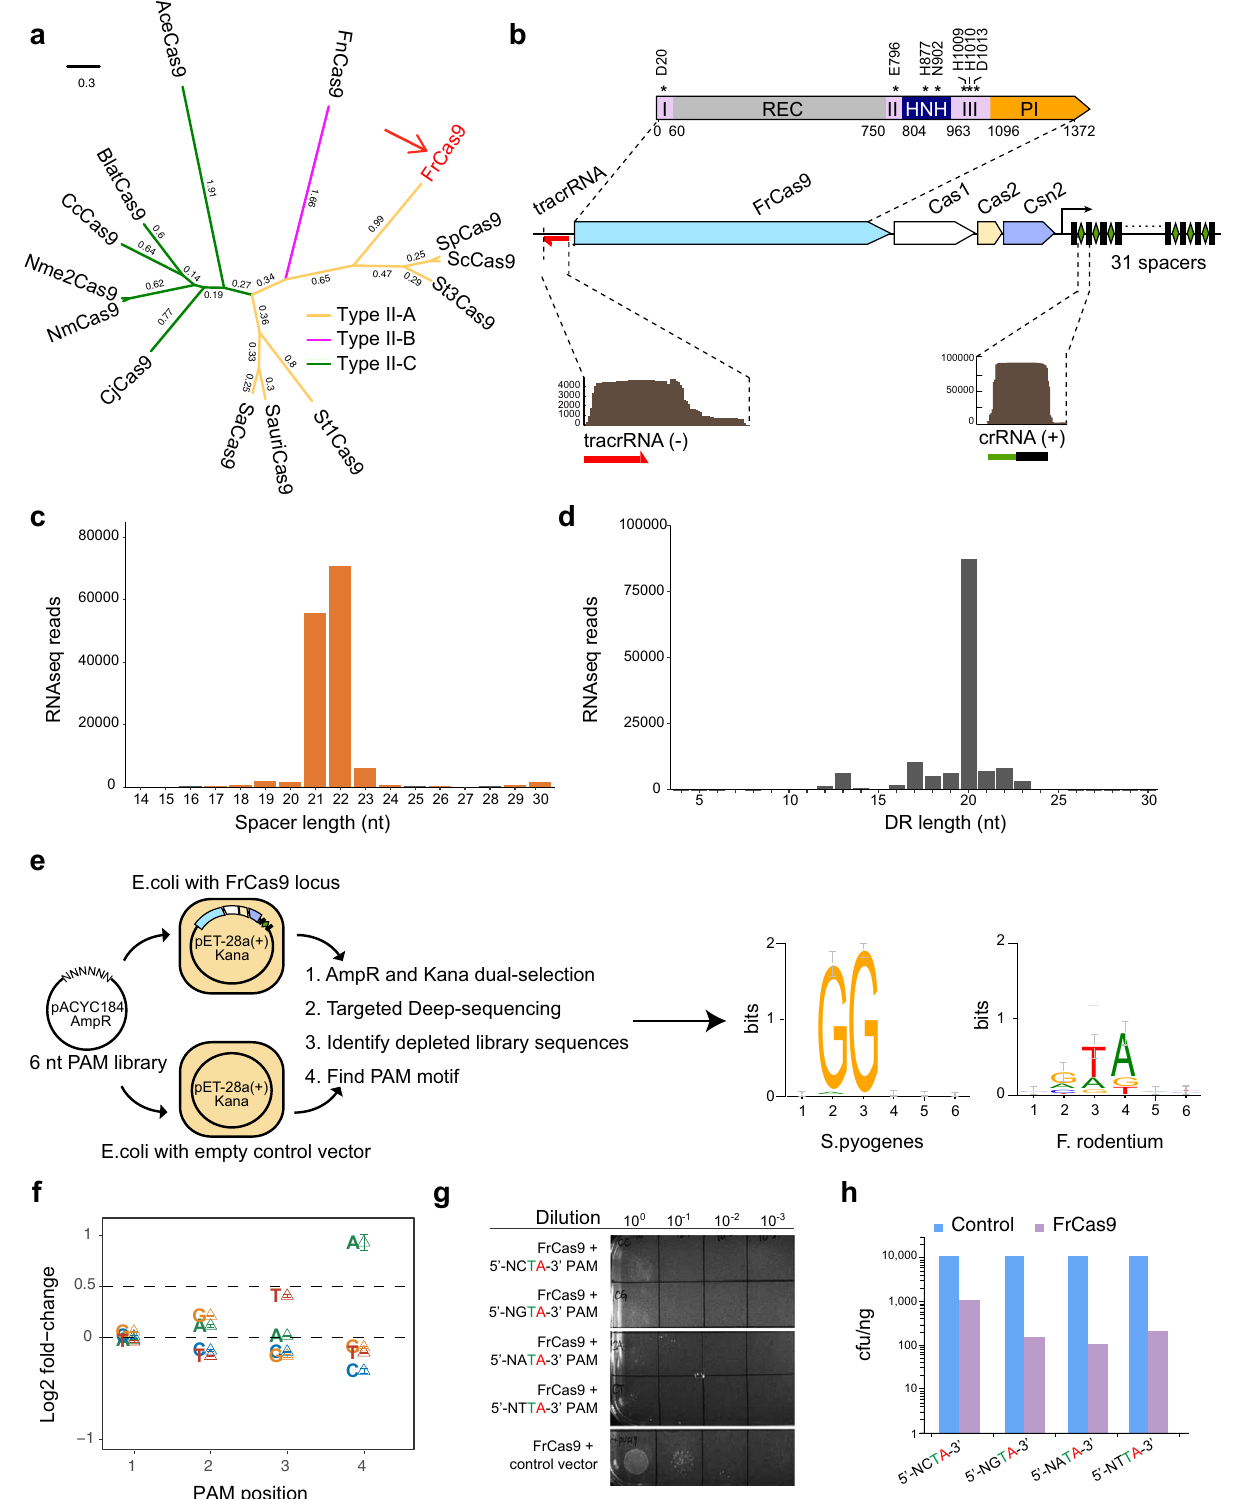
Fig. 1 FrCas9 edits distinct 5 ′ -NNTA-3 ′ PAMs. a The phylogenetic tree of FrCas9 and 13 active Cas9 orthologs. b The schematic of Faecalibaculum rodentium systems. Insert above displayed the domains of FrCas9 with active residues indicated with asterisks. I, II, III represented three RuvC domains. Insert below showed expressed crRNA and tracrRNA from small RNA-seq of E. coli harboring pET-28A plasmid with simpli fi ed FrCas9 locus. c Distribution of the length of spacer sequences derived from small RNA sequencing. d Distribution of the length of DR sequences derived from small RNA sequencing. e The schematic of depletion assay and web-logo results for SpCas9 and FrCas9. f The deletion effects of fi rst four nucleotides of FrCas9 PAM. Data are presented as mean values ± S.E.M. ( n = 4). g The plasmid interference assay of FrCas9 in 4 sites that differed in the 2 nd PAM positions. A series of dilution was performed. h The bar plot of cell units of above plasmid interference assay. Source data are provided with this paper.